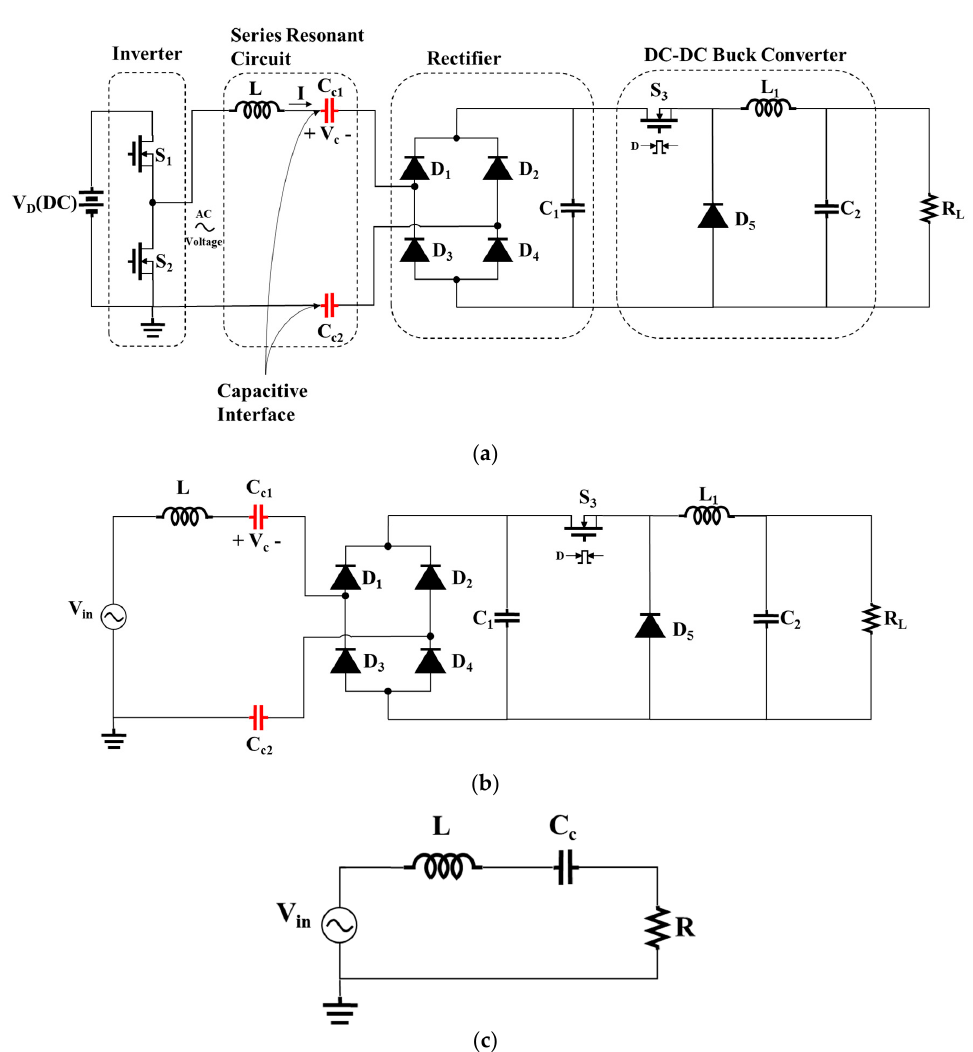
Figure 2. The proposed system: ( a ) CPT system with a DC–DC buck converter; ( b ) circuit simplification by the sinusoidal approximation, and ( c ) equivalent circuit used for analysis.